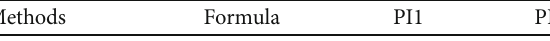
Table 2: Method for calculating the scale of lateral accretion body.